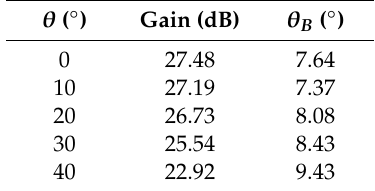
Figure 20. Antenna gain for scanning angle 0° to 40° . Table 10. Simulation results of different feed positions.